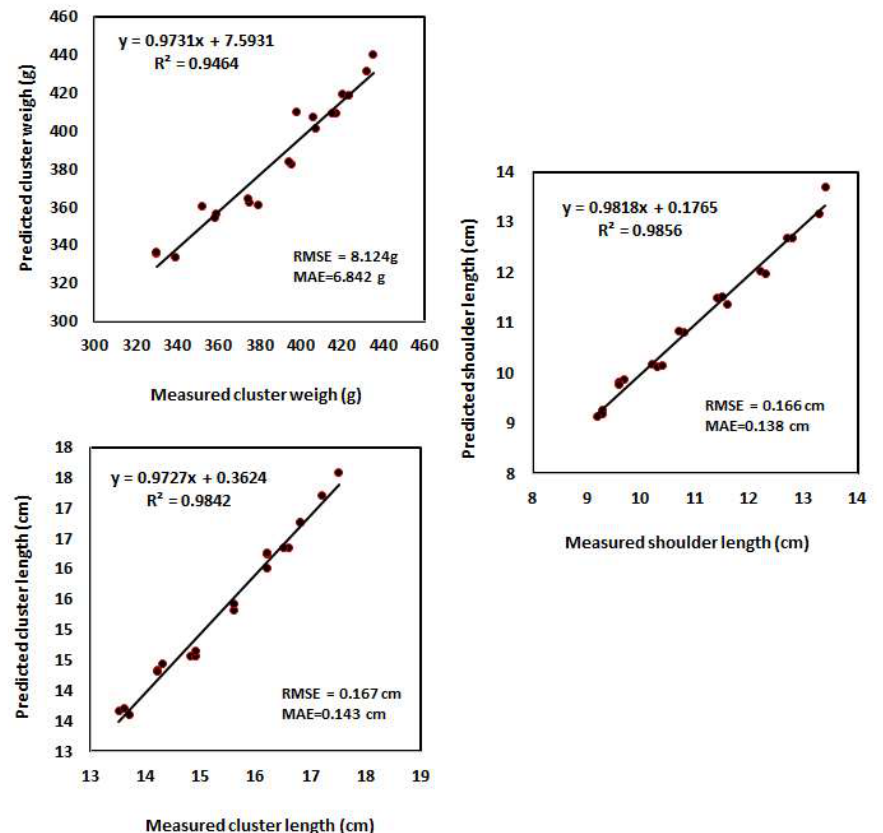
Figure 2. Regression analysis between measured and predicted cluster weight, cluster length, and cluster shoulder length for the test set.